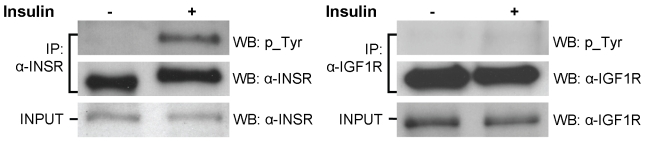
INSR activation following insulin treatment in human primary fibroblasts.Fibroblasts were serum starved for 18 h and then treated with 100 nM insulin for 5 min. Cell lysates were incubated with α-INSR or α-IGF1R antibodies. Input and immunoprecipitated products were analyzed by western blots using α-phosphotyrosine, α-INSR, or α-IGF1R antibodies.